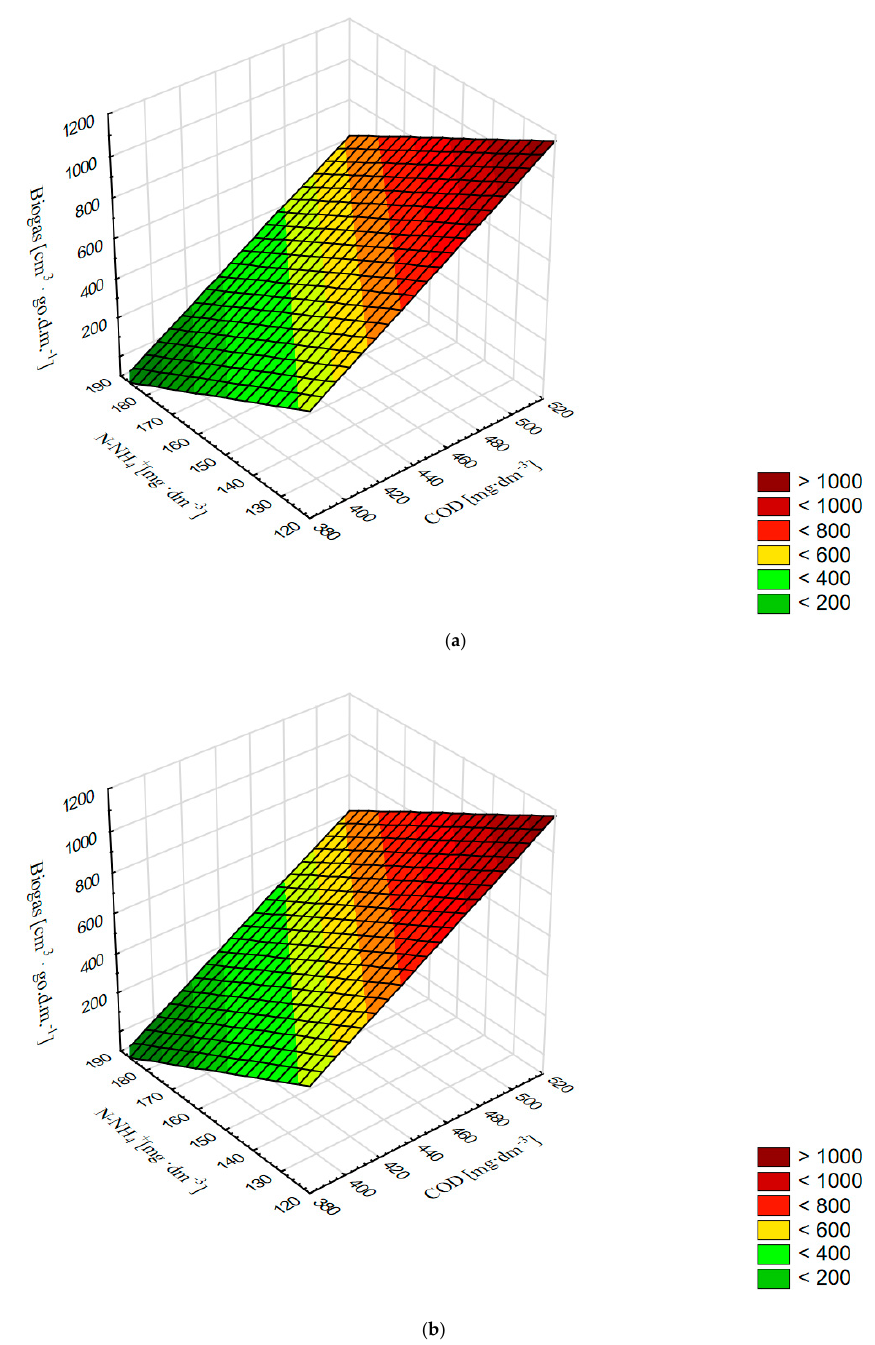
Figure 5. Surface dependency between COD and N-NH 4+ concentrations and ( a ) biogas production and ( b ) methane production.